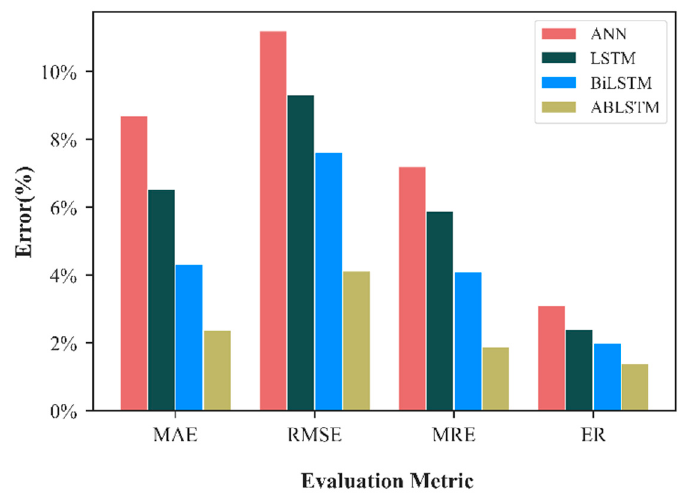
Figure 15. Performance comparison among different models. Table 6. Standard Deviation of RUL Prediction Errors.